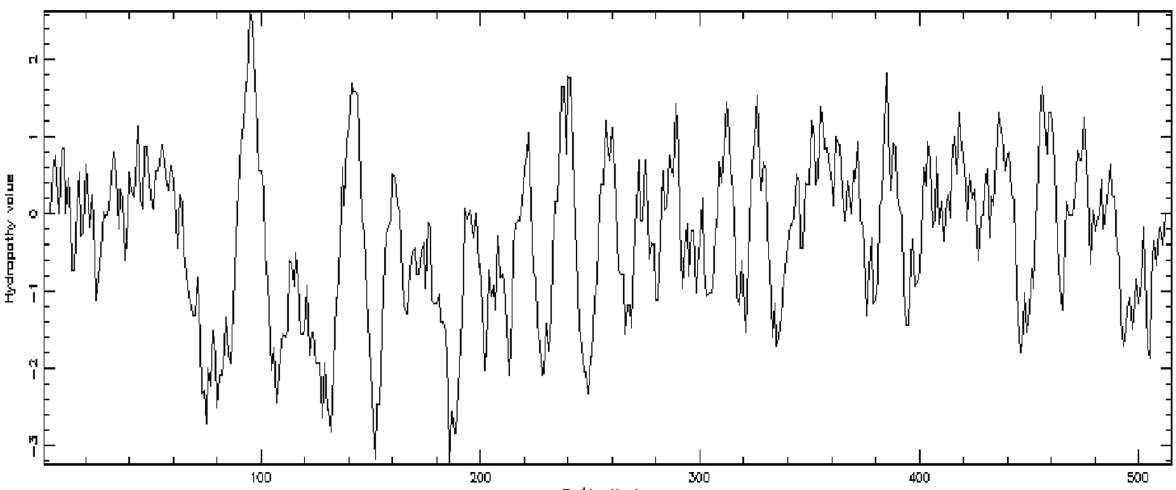
Fig. 4 Hydropathy plot of RegO, using Kyte and Dolittle hydropathy parameters. Showing that RegO is a cytoplasmic not a membrane bound sensor his Kinase